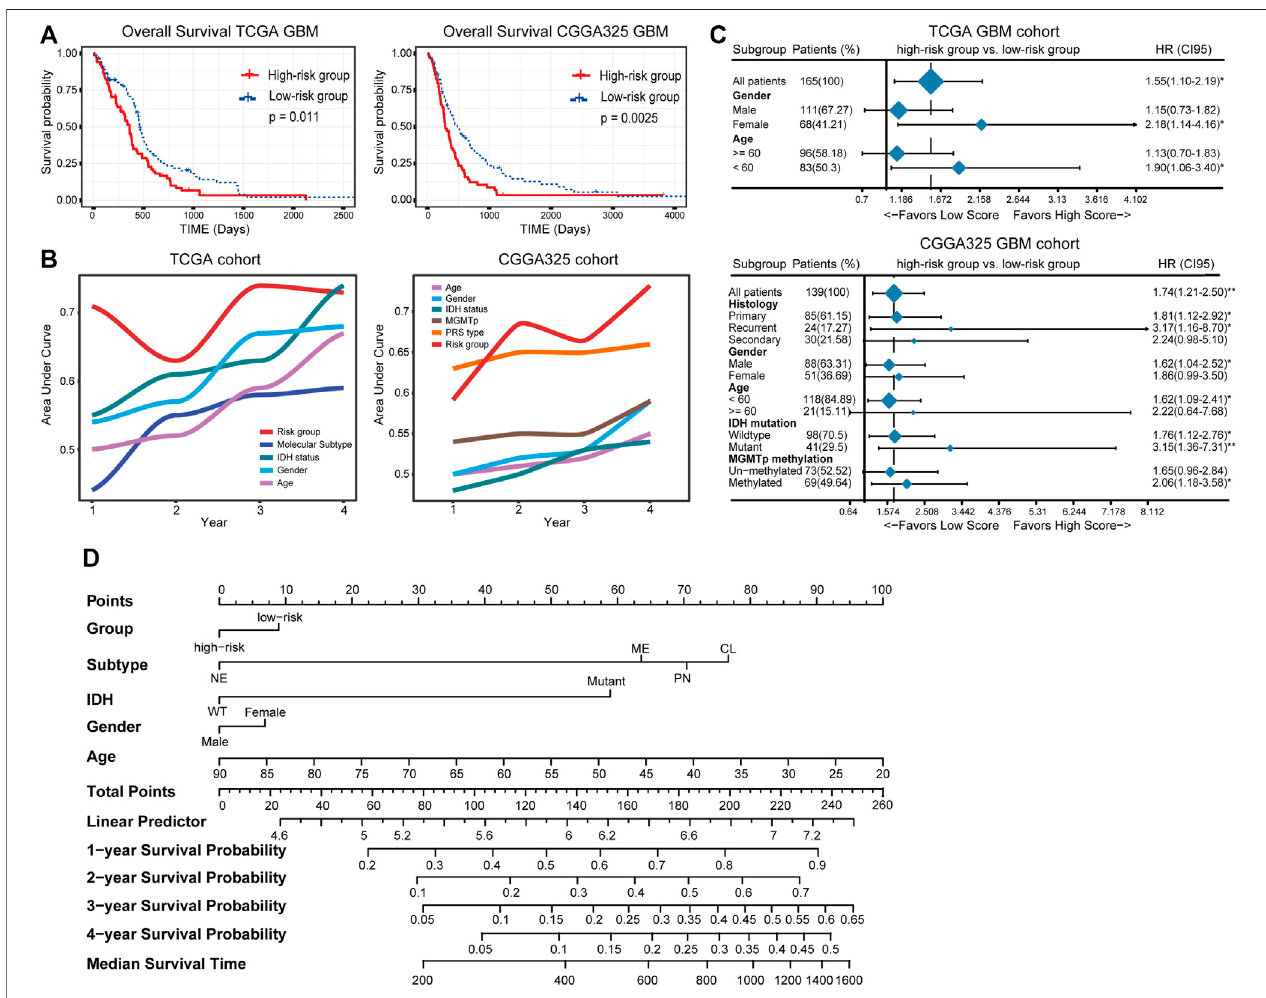
FIGURE 3 | (A) The distinct overall survival between the high- and low-risk groups. (B) The time-dependent predictive power of the risk model and other prevalent clinicopathological parameters. PRS type: primary, recurrent, secondary type of the tumor. (C) The independent prognostic value of the risk score. (D) Nomogram demonstrating time-dependent survival rate for patients with different pathological parameters in clinical